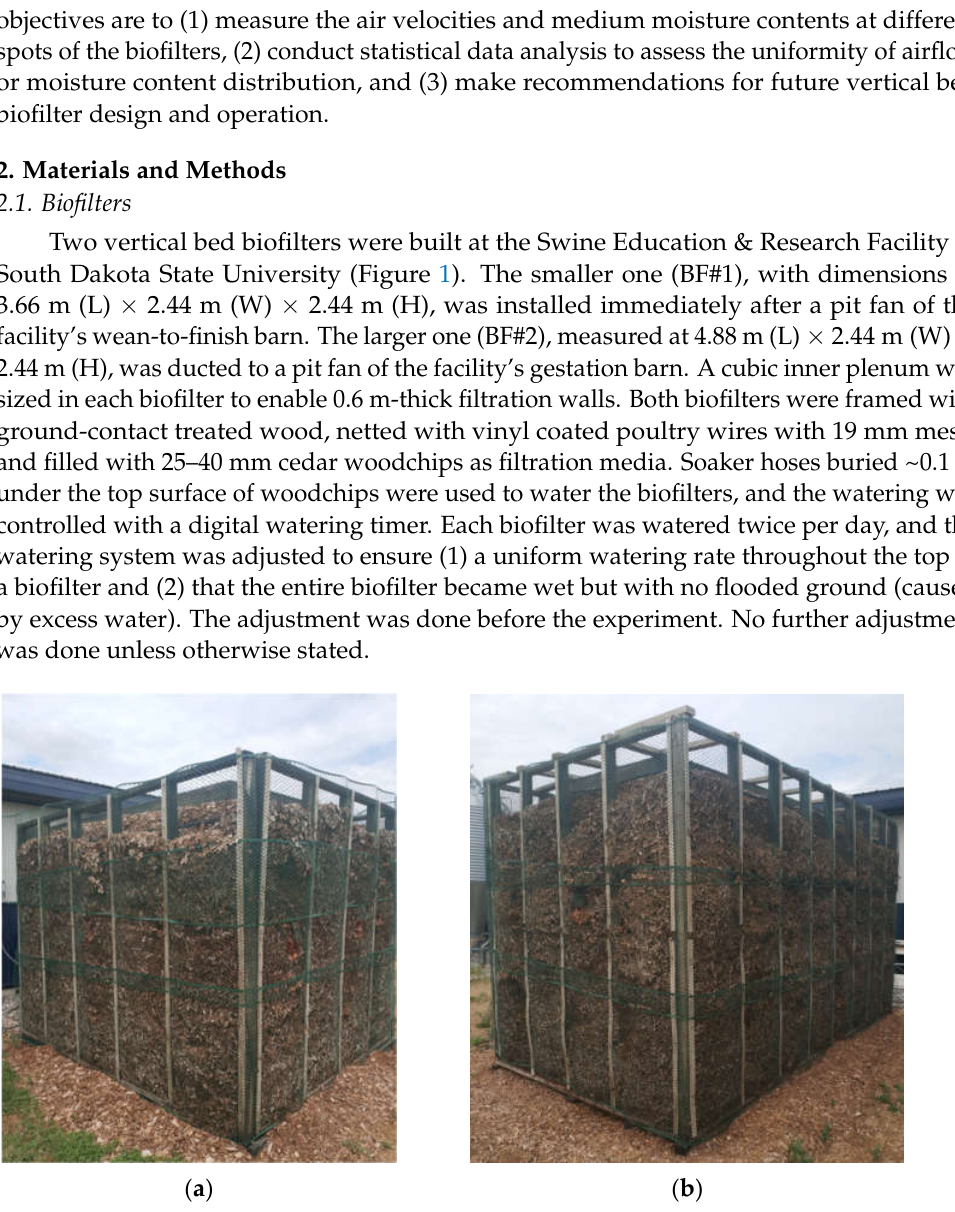
Figure 1. Photos of ( a ) the smaller biofilter (BF#1) outside of a wean-to-finish barn; and ( b ) the larger biofilter (BF#2) outside of a gestation barn.